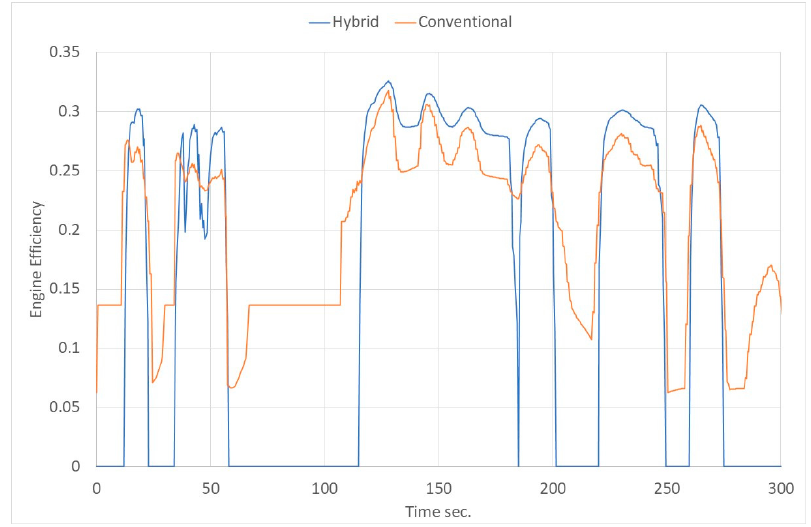
Figure 11. Efficiency of ICE running the WLTC Class1 driving cycle. Figure 11. E ffi ciency of ICE running the WLTC Class 1 driving cycle.